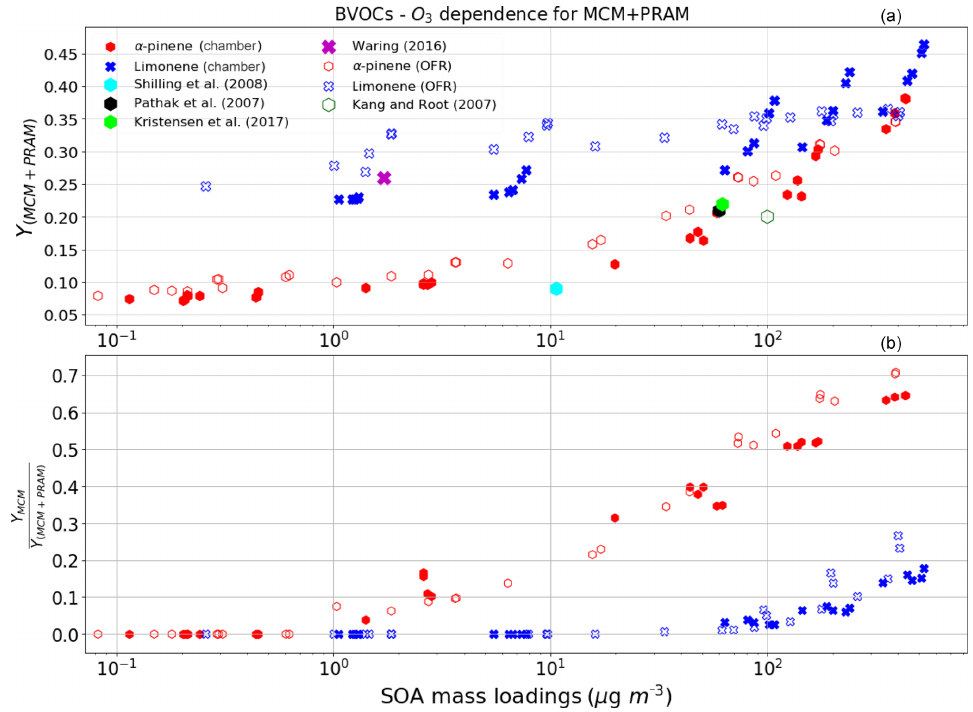
Figure 1. The mass yields from the ozonolysis of BVOCs α -pinene (red heptagon) and limonene (blue crosses) modeled after chamber (filled symbols) and flow-tube settings (open symbols). The figure shows a comparison of SOA mass yields obtained from simulations with MCM + PRAM (a) and ratio of yields from MCM and MCM + PRAM (b) . Currently PRAM is available for ozonolysis of limonene and α -pinene. The clumps are a result of SOA mass yields for the oxidation of specific oxidant concentrations with varying BVOC